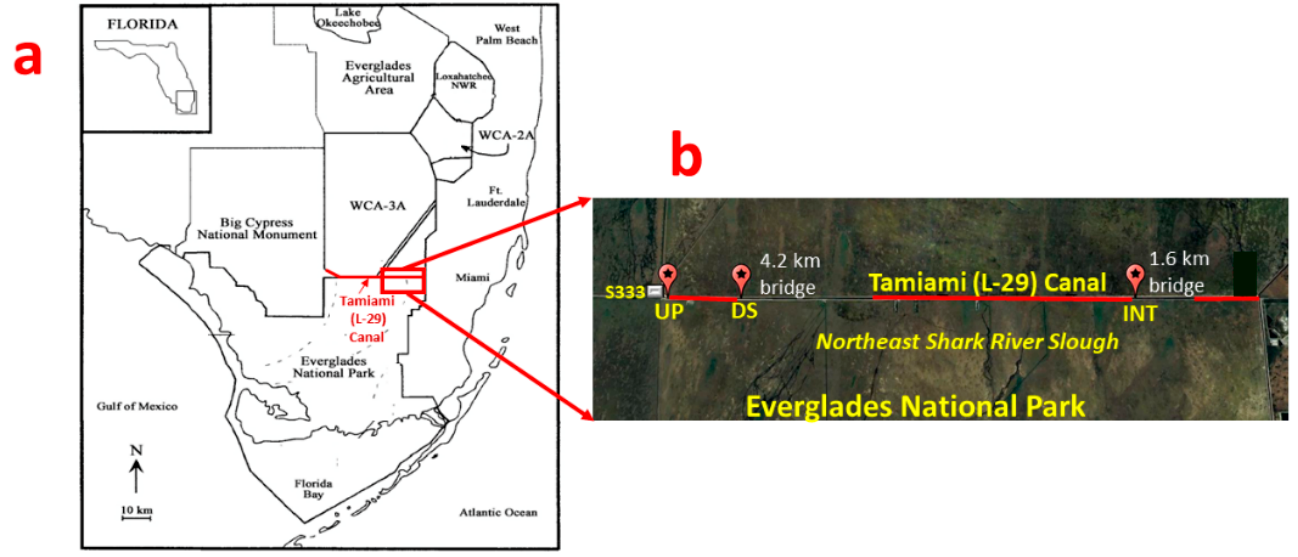
Figure 1. ( a ) Map of the Everglades region showing the Tamiami (L-29) Canal (in red) and ( b )